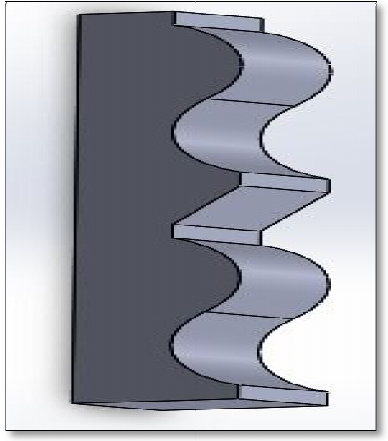
Fig. 1. Shown the design of free